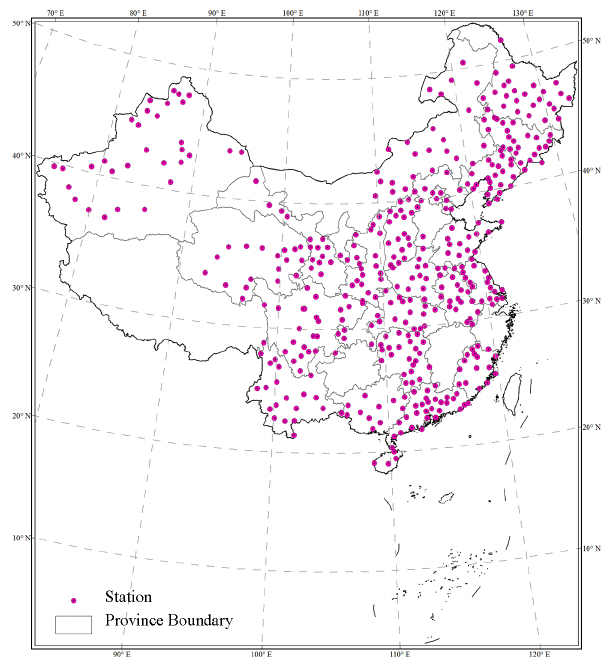
Figure 1. The location of meteorological stations across mainland